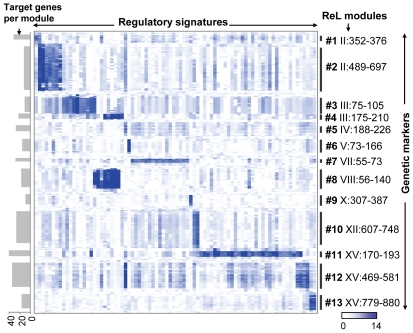
The ReL matrix.A matrix of genetic markers (rows) versus regulatory signatures (columns), where the colors indicate the ReL score. A blue (white) entry indicates significant (non-significant) ReL score. Shown are only columns and rows that are part of at least one ReL module as well as five additional flanking genetic markers on the boundaries of the module's linkage interval. Genetic markers are displayed according to their genomic order, and the modules' linkage intervals are shown as black vertical lines. Columns are grouped according to the biclustering solution whereas columns that are shared among multiple modules are assigned to one of their modules arbitrarily. The visualization highlights the existence of high intensity sub-matrices (modules) within the ReL matrix. The number of target genes in each module is shown as gray bars on the left.